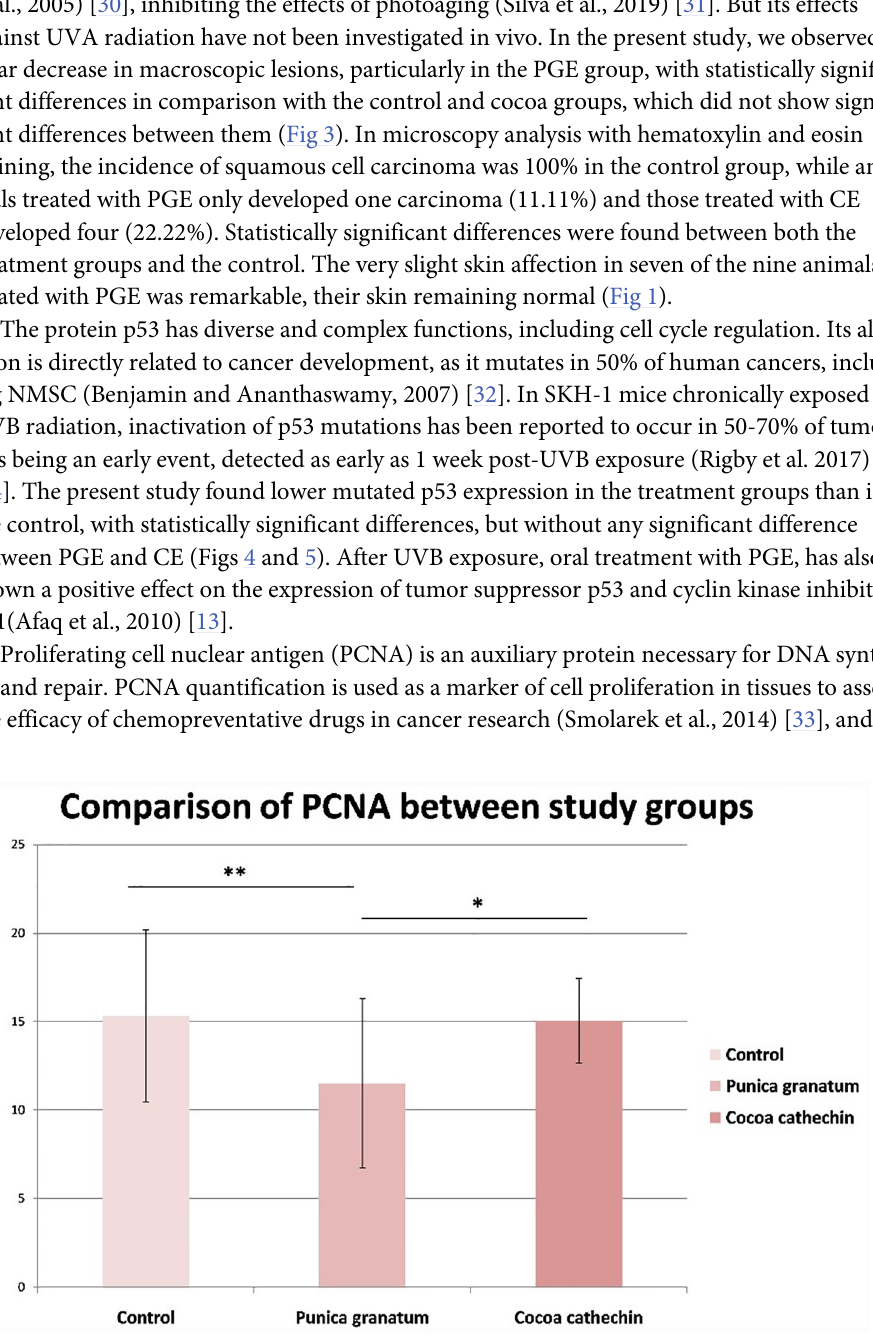
Fig 6. Comparison of percentage of proliferating cell nuclear antigen (PCNA) immunohistochemical positive cells in relation to the total number of cells between study groups (Tukey test). Significant difference ( � p � 0.050; �� p <